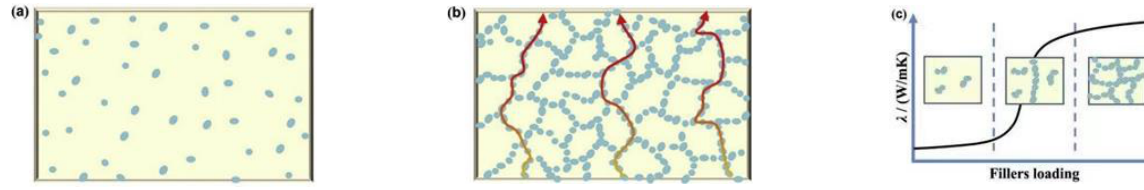
Figure 2. Schematic diagram of heat conduction mechanism ( a ) “ Sea Island ” under low filler loading; ( b ) Heat conductive path under high filler loading; ( c ) Change in the thermal conductivity of the composite materials. ( a – c ) Adapted with permission [16], Copyright 2020, Elsevier Ltd.